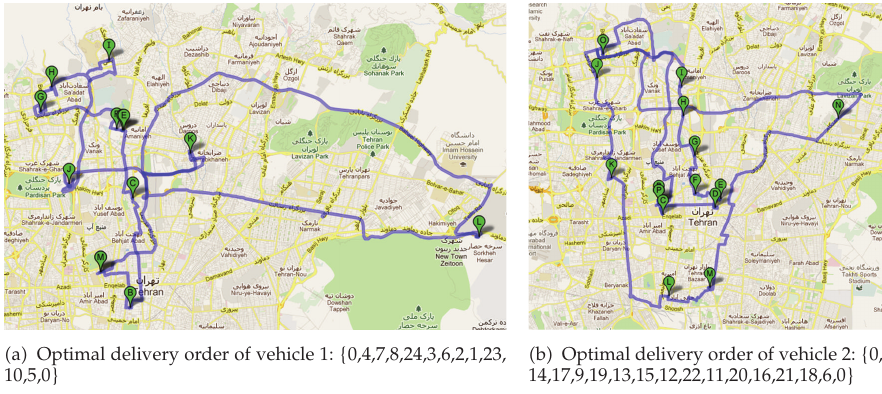
Figure 4: The optimal delivery orders when hiring two vehicles, (cid:6) a (cid:7) vehicle 1, and (cid:6) b (cid:7) vehicle 2.